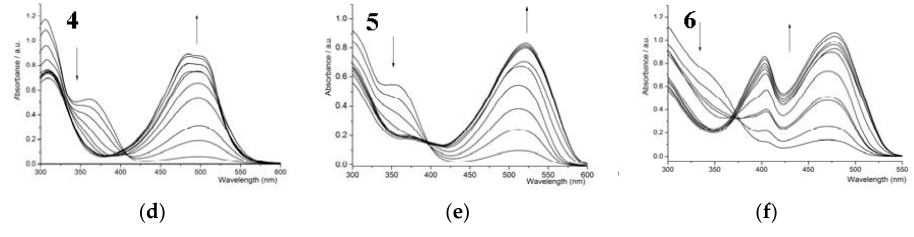
Figure 2. UV-Vis spectral changes of six compounds with acetate anion addition. [compound] = 4.0 × 10 − 5 mol·L − 1 ; [acetate anion] = 0–1.6 × 10 − 3 mol·L − 1 . Arrows indicate the direction of increasing anion concentration. ( a ) Compound 1 ; ( b ) Compound 2 ; ( c ) Compound 3 ; ( d ) Compound 4 ; ( e ) Compound 5 ; ( f ) Compound 6 .